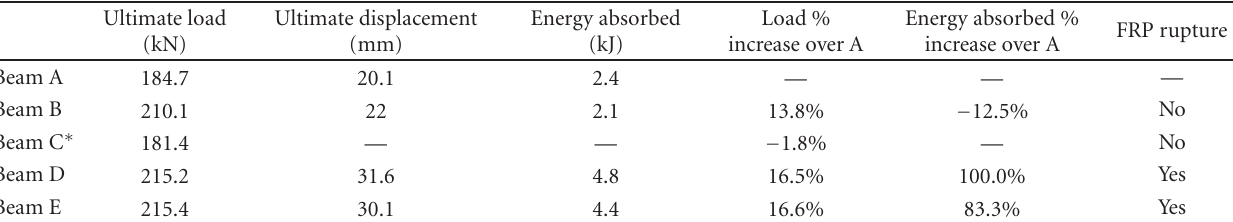
Table 2: Summary of results: boracol treated.